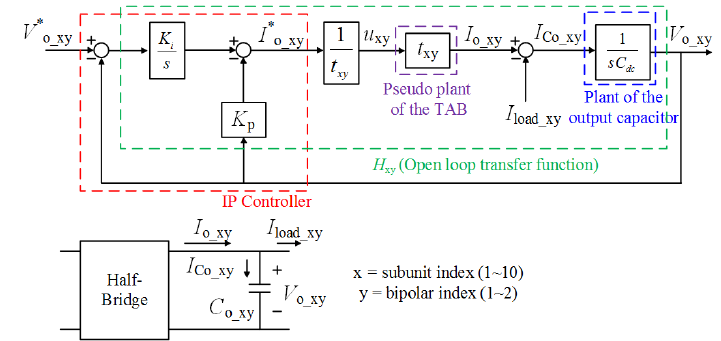
Figure 7. Block diagram of the voltage controller converted to SISO